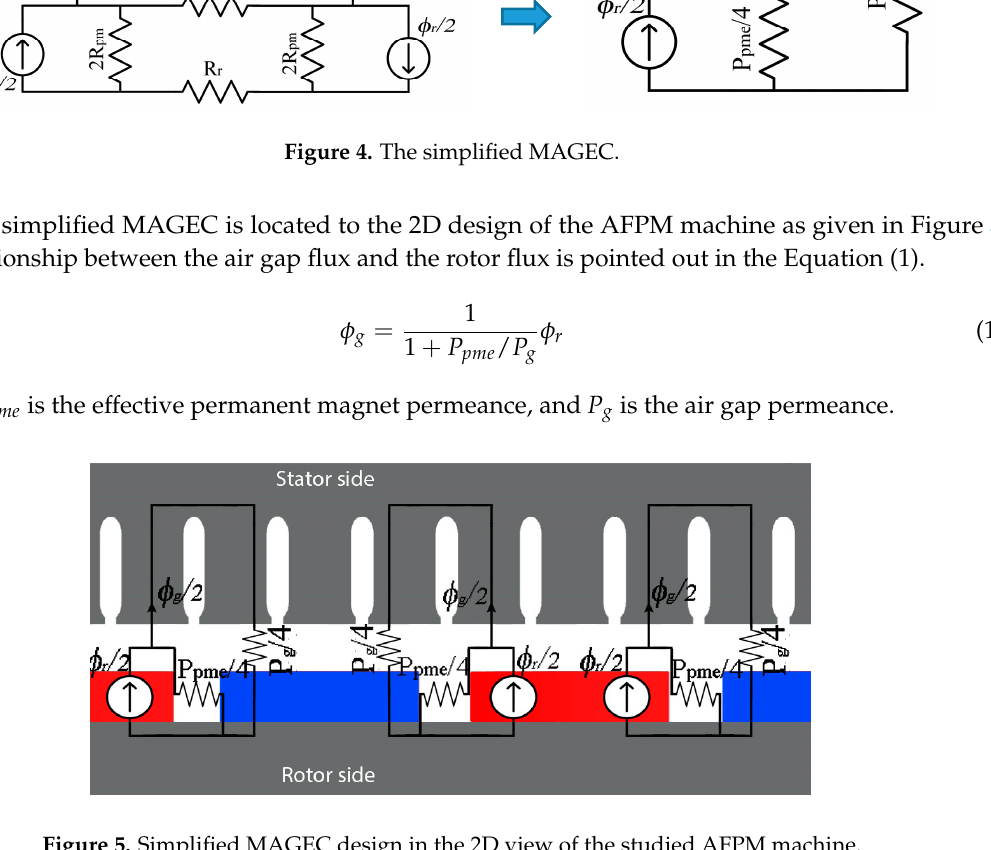
Figure 5. Simplified MAGEC design in the 2D view of the studied AFPM machine. Table 2. Data of the permanent magnet and the steel.